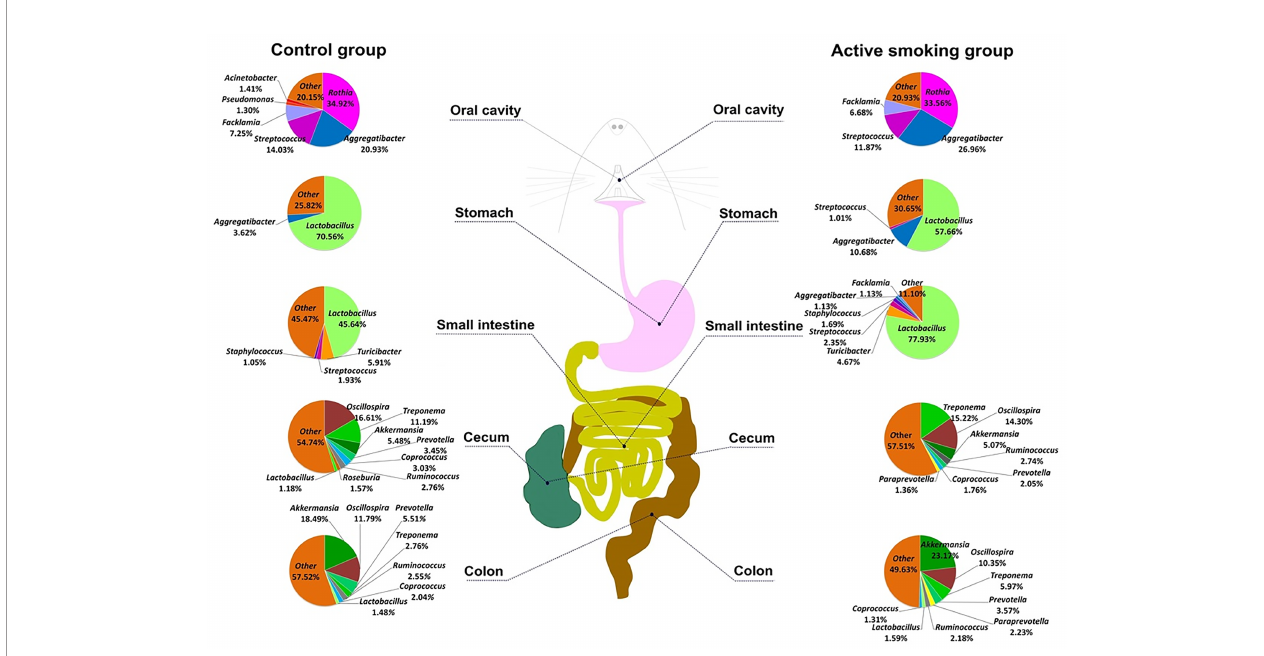
FIGURE 2 | The schematic of the digestive tract of rats and constituents of the microbiome in the control and active smoking groups. Pie charts for the bacterial genera at fi ve regions along the digestive tract according to the median relative abundance. Each genus is indicated by different colors. Genera with a relative abundance lower than 1% are labeled together as ‘ others ’ (orange).